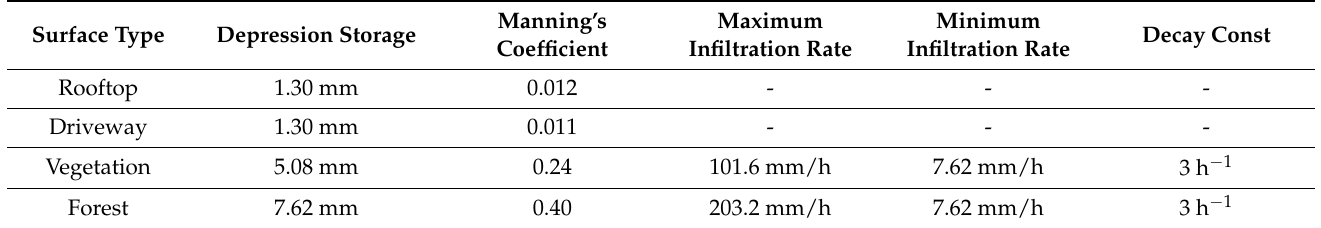
Table 2. Depression storage depths, roughness coefficient and infiltration parameters.